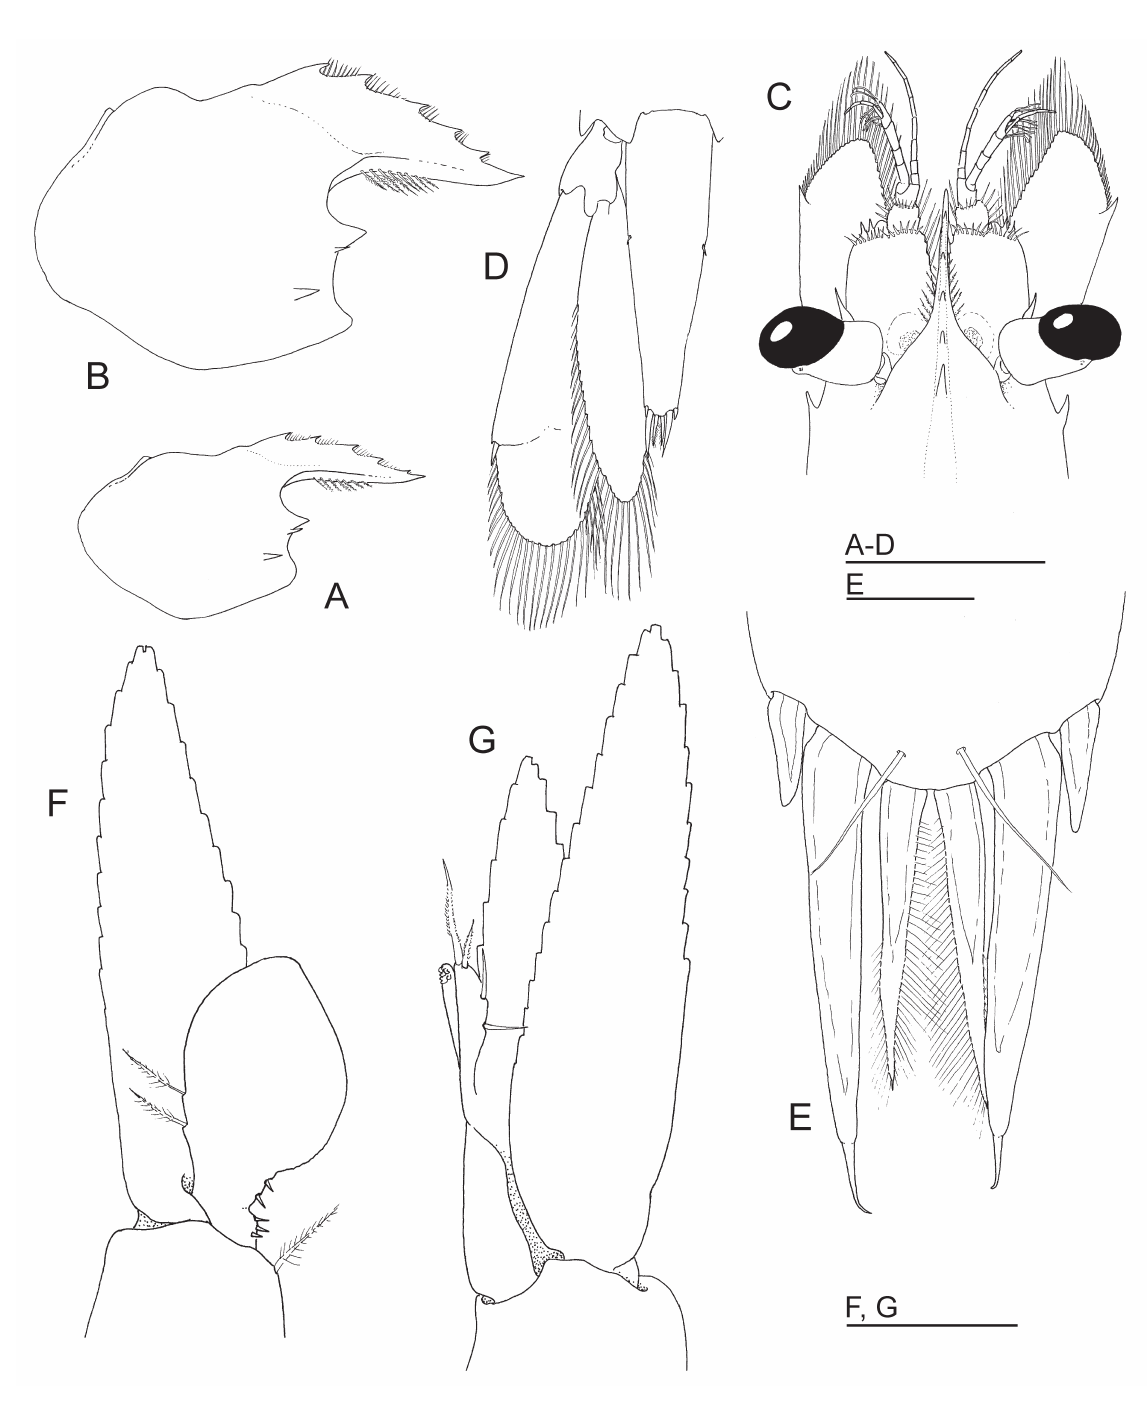
Fig. 7. Hamodactylus pseudaqabai sp. nov., ♂, allotype (PoCL 1.4 mm, N. Sulawesi, RMNH. CRUS.D.57007) (A, F–G), and ovigerous ♀ (PoCL 2.2 mm, Sabah, Malaysia, RMNH.CRUS.D.53969) (B–E). A–B . Carapace and rostrum, lateral view. C . Anterior carapace and appendages, dorsal view. D . Tail fan, dorsal view. E . Same as previous, tip of telson. F . First male pleopod. G . Second male pleopod. Scale bars: A–C = 2 mm; D = 1.25 mm; E = 0.25 mm; F–G = 1